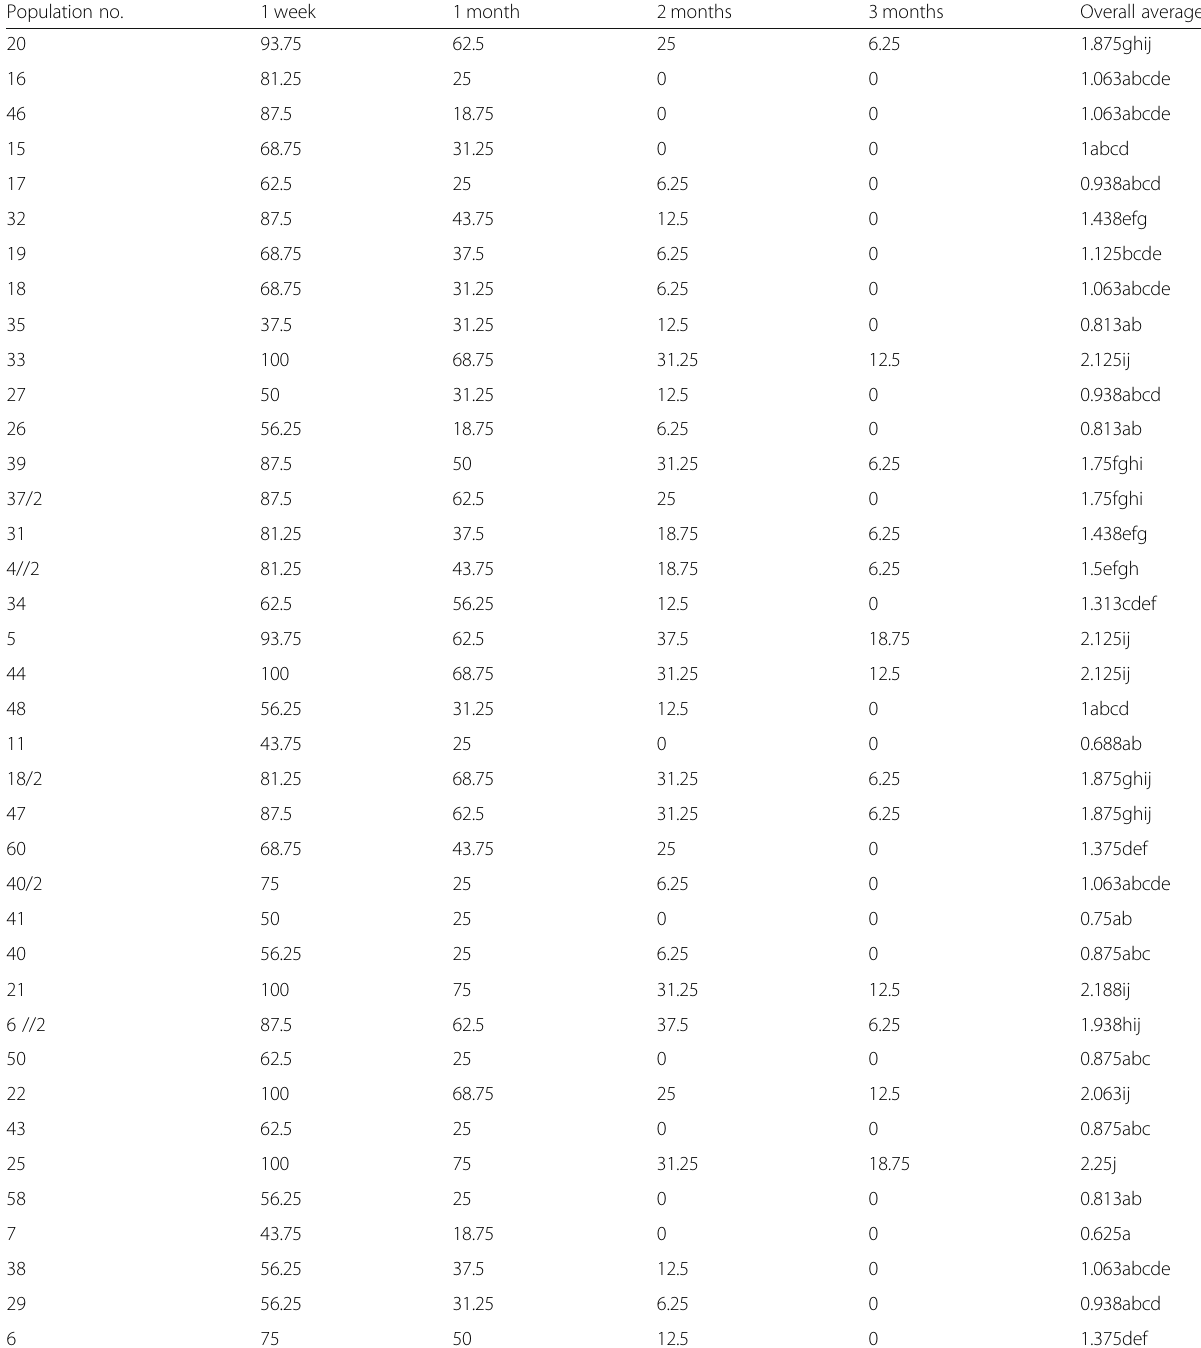
Table 2 Percentage mortality of Galleria mellonella last instar larvae exposed to 38 Heterorhabditids indica populations at 4 baiting times post-inoculation Population